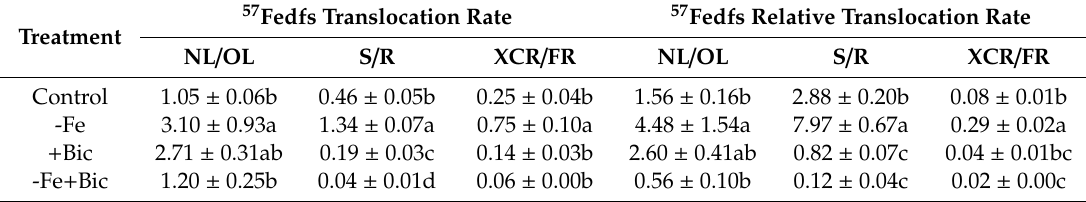
Table 2. 57 Fedfs translocation di ff erences in various parts of kiwifruit plants treated with -Fe, + Bic or -Fe + Bic in solution culture for 28 days. Values are means of three replicates ± SE. Di ff erent letters indicate significant di ff erences among the treatments at p < 0.05. NL, new leaves; OL, old leaves; S, shoots; R, roots; XCR, xylem of coarse roots; FR, fine roots.